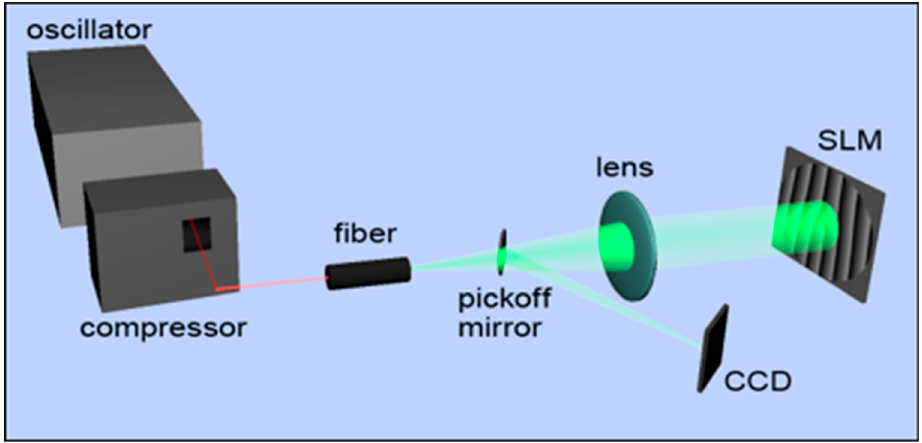
Figure 5. Experimental setup for generation of white-light vortices from a femtosecond source, with a spatial light modulator.